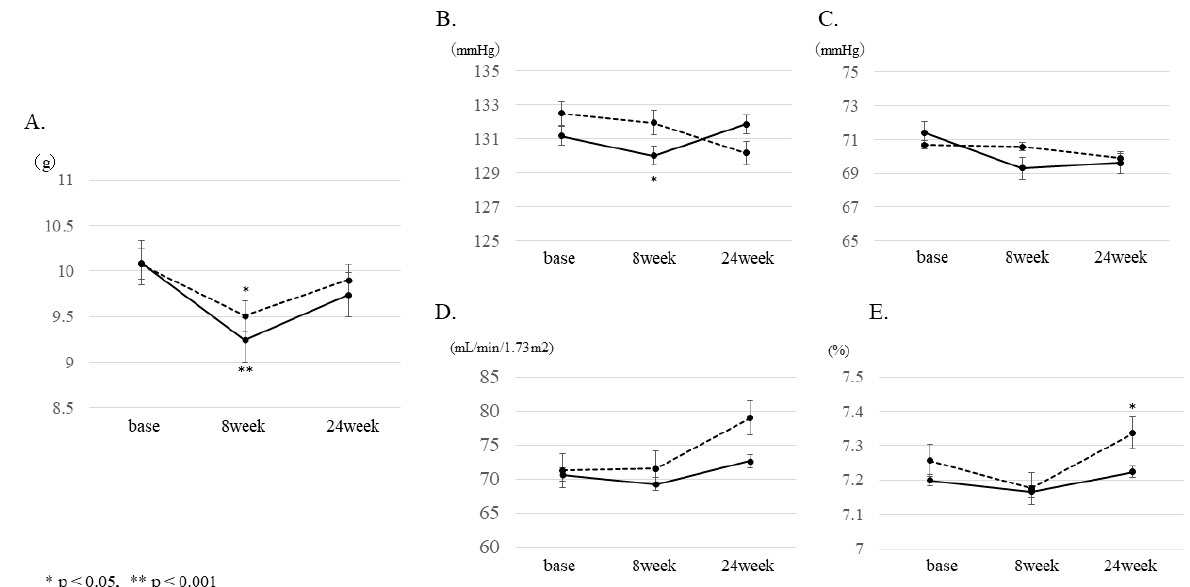
Figure 1. Changes at 8 and 24 weeks from baseline. Changes at 8 and 24 weeks from baseline were compared between the intervention group (IG) and control group (CG) using mixed models for ( A ) estimated salt intake, ( B ) systolic blood